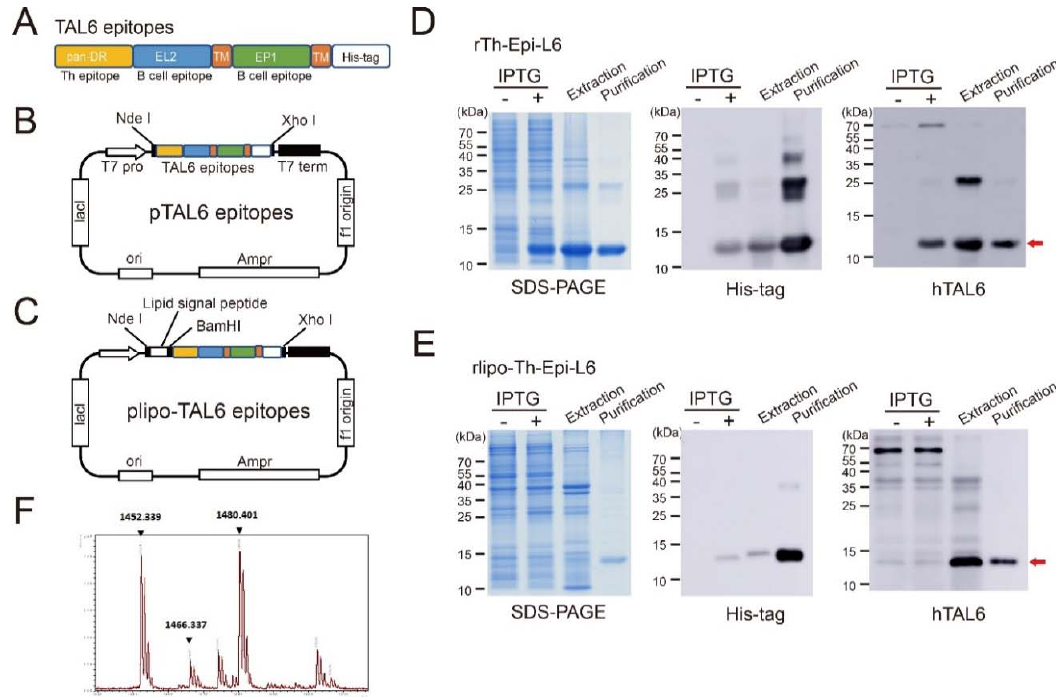
Figure 1. Characterization of recombinant non-lipidated (rTh-Epi-L6) and lipidated (rlipo-Th-Epi-L6) polyepitope vectors and proteins. ( A ) Epitopes of TAL6. The epitopes of TAL6 which trigger di ff erent immune cell response were sequentially combined with a HisTag sequence at the C-terminus. Pan-DR, helper T epitope; EL2, extracellular loop of TAL6; TM, transmembrane sequence (AAALLMLLPAFV); EP1, B cell epitope. ( B ) Plasmid pTAL6 was constructed by inserting the TAL6 epitopes into vector pET22b for production of the rTh-Epi-L6 protein. ( C ) Plasmid plipo-TAL6 was constructed by adding the D1 sequence to the pTAL6 vector for production of the rlipo-Th-Epi-L6 protein. ( D ) rTh-Epi-L6 expression and purification were monitored by reducing SDS-PAGE (left) and Western blotting with anti-HisTag (middle) and TAL6 (right) antibodies. ( E ) rLipo-Th-Epi-L6 expression and purification were monitored by reducing SDS-PAGE (left) and Western blotting using anti-HisTag (middle) and TAL6 antibodies (right). ( F ) Mass spectrometry analysis of rlipo-Th-Epi-L6. After the digestion of rlipo-Th-Epi-L6 with trypsin, the sample was analyzed by MALDI-TOF. The spectrum showed 3 peaks with m / z values of 1452, 1466 and 1480, corresponding to the expected mass di ff erences for a lipidated